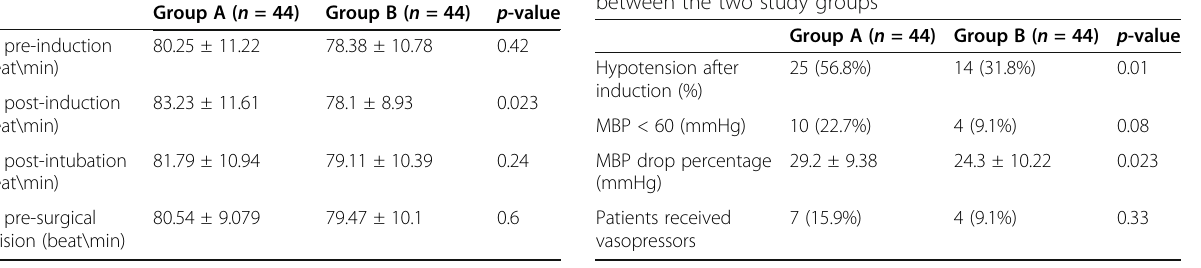
Table 4 Comparison of hypotensive rates after induction between the two study